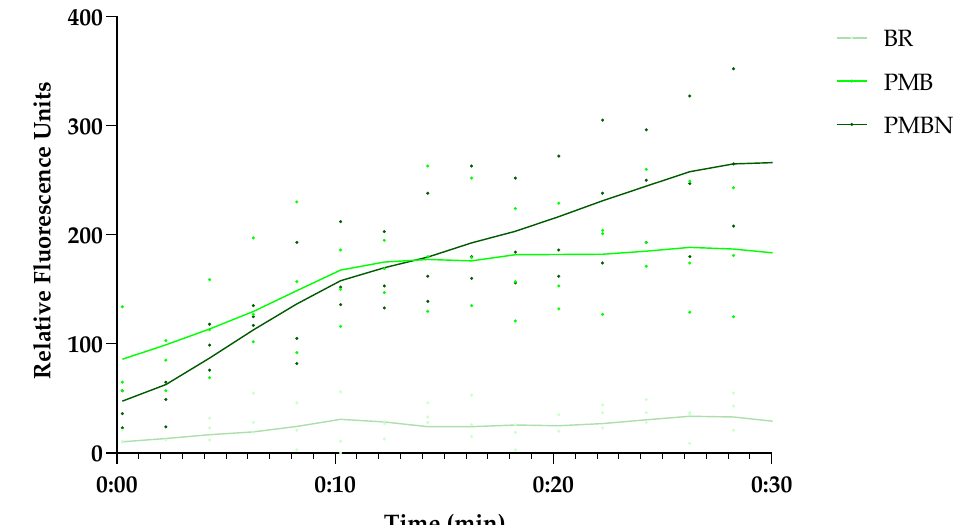
Figure 6. Both the OM-active PMBN and PMB induce UnaG fluorescence in the presence of BR, but show differences in the kinetics over time. The 30 min fluorescence kinetics of UnaG in E. coli MC4100 after exposure to 10 µ g/mL PMB and 5 µ M BR (medium green), 10 µ g/mL PMBN and 5 µ M BR (dark green), or 5 µ M BR only (light green). The data points represent three independent measurements normalized to the negative control in the presence of bacteria only. The mean is represented by the solid line of the same color.